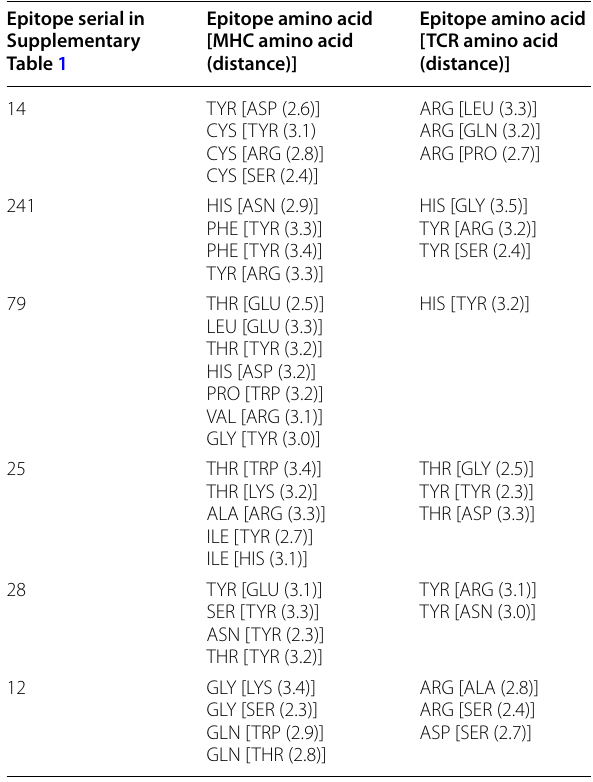
Table 3 The amino acids and bond distances between the proposed epitopes and both MHC and TCR Epitope serial in